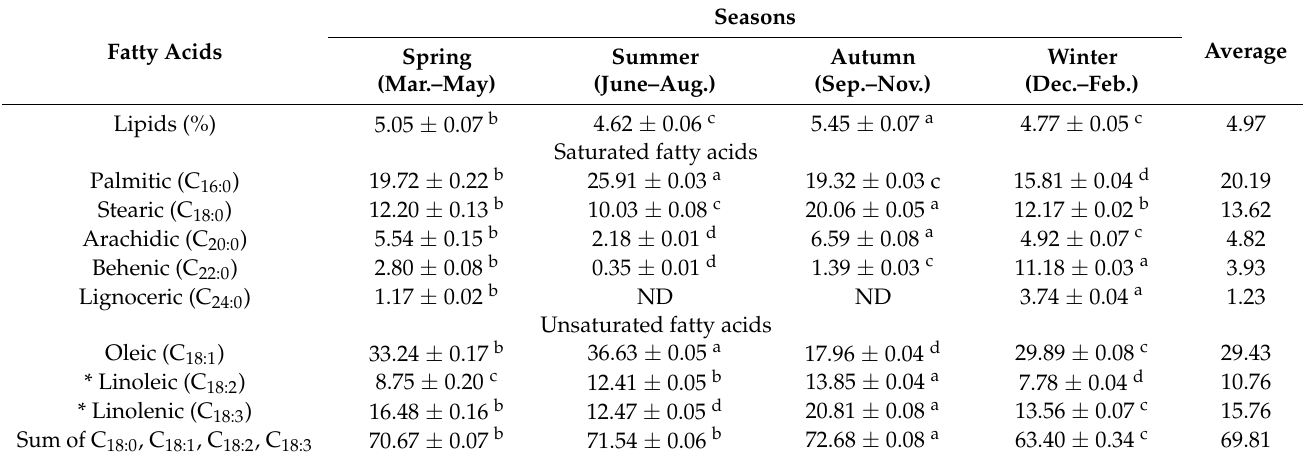
Table 2. Lipids and fatty acids content (% dry matter, DM) of honeybee pollen loads harvested from the Al-Ahsa oasis.